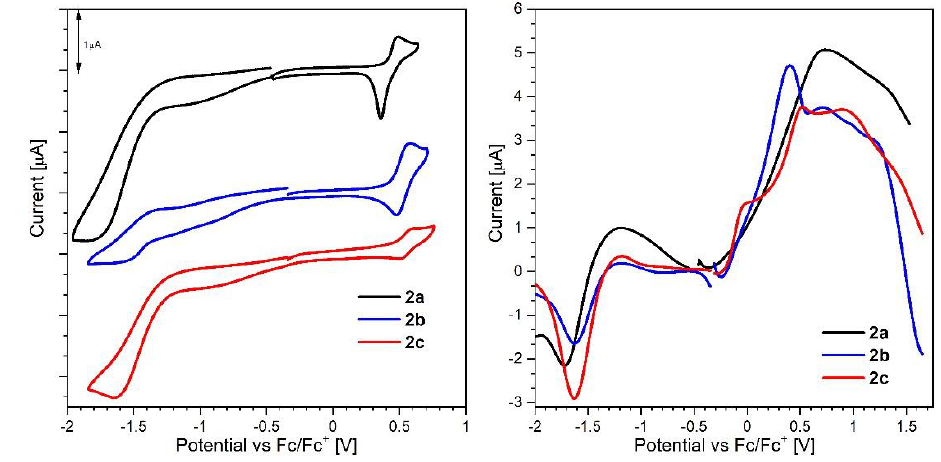
Figure 1. CV and DPV curves of 2a–2c in a dichloromethane solution. The measurements were performed with a platinum working electrode and referenced against an Fc/Fc + couple, scanning rate 50 mV/s.